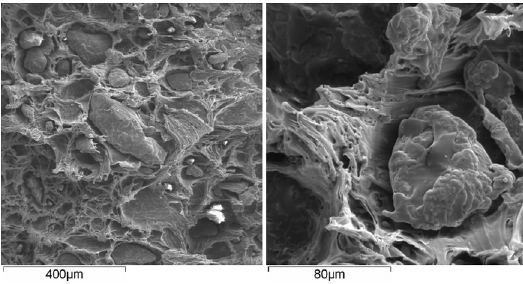
Figure 8. SEM micrographs of fractured surfaces of 80/10LDPE/ PHB/10 CC mixture at low and high